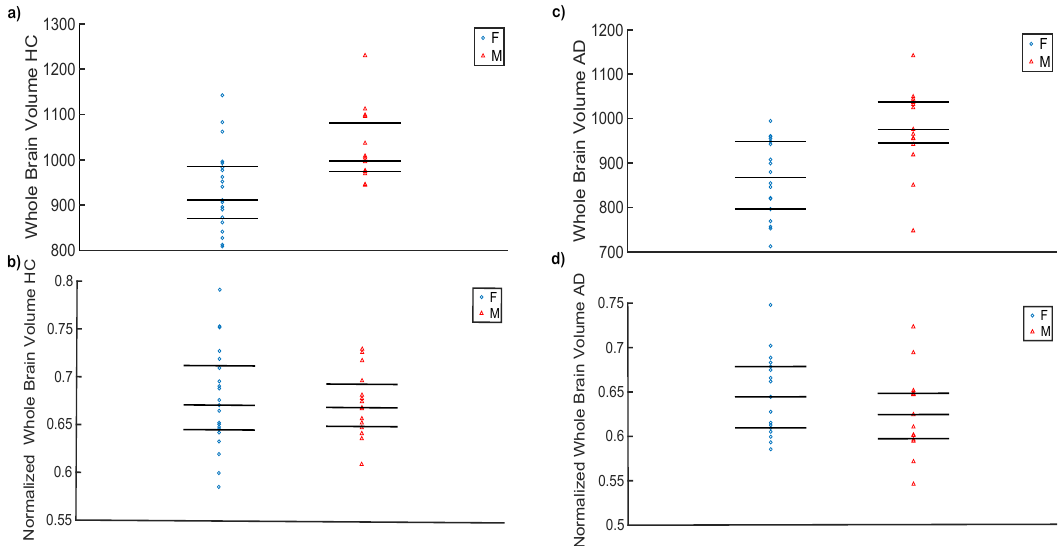
Figure 2. Statistical differences in whole brain volume between male and female subjects for the HC group ( a ) and AD group ( c ) ( p < 0.05). After whole brain normalization ( V n ), the scatter plots show a similar range of variation for both HC ( b ) and ADs ( d ) subjects ( p >